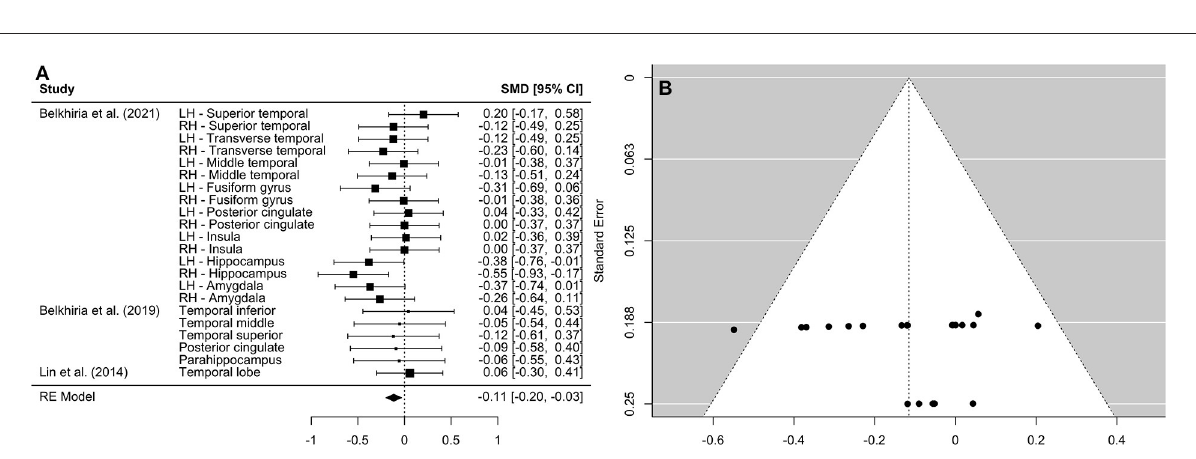
FIGURE3 Forest plot (A) and funnel plot (B) of the temporal lobe analysis. In the forest plot (A) negative values on the x-axis indicate gray matter